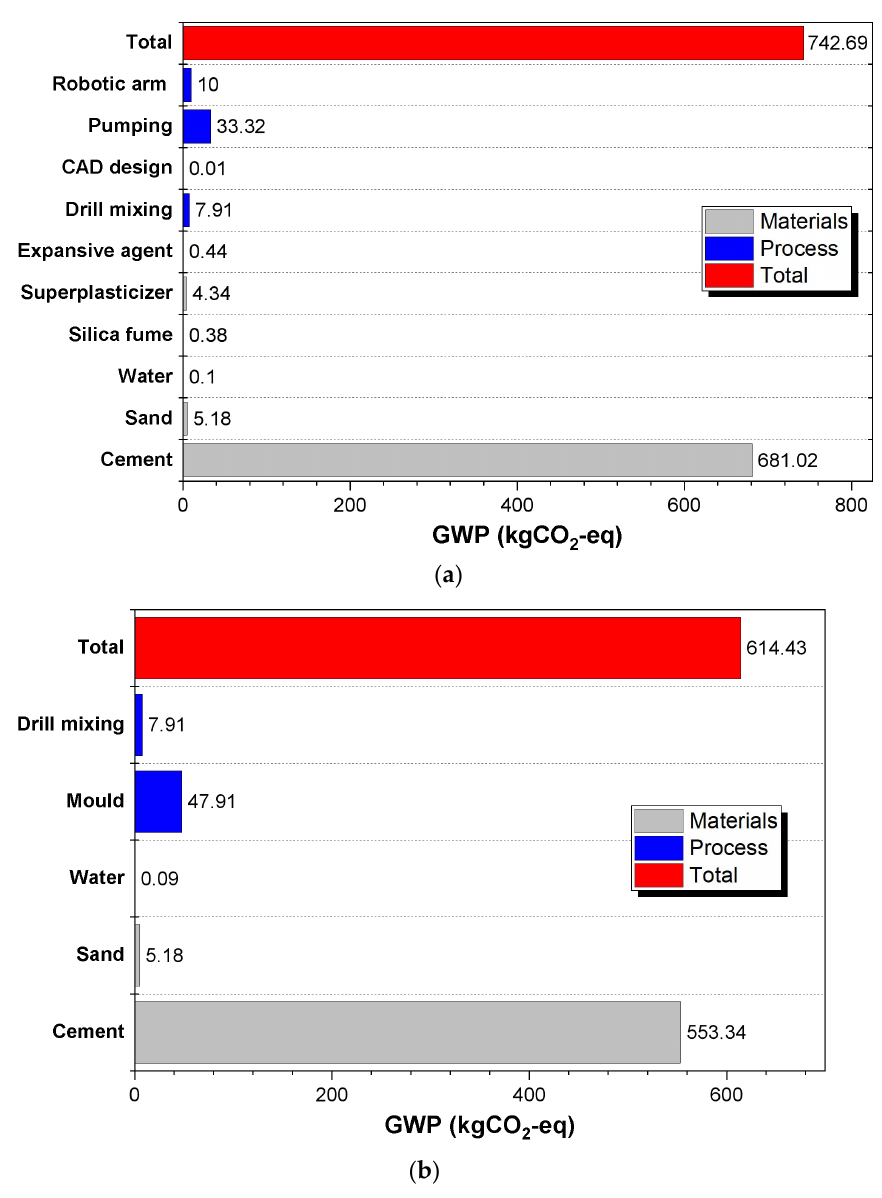
Figure 2. GWP results: ( a ) p-CTR and ( b ) c-CTR.